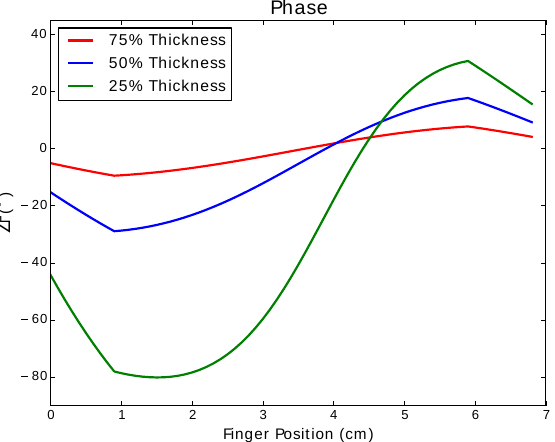
Figure 14. Phase of the reflection coefficient of a simulated quarterwave short-circuit stub using a